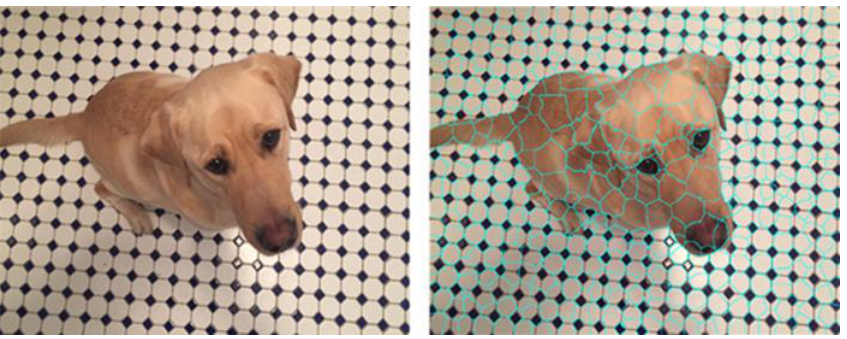
Figure 2. SLIC superpixel